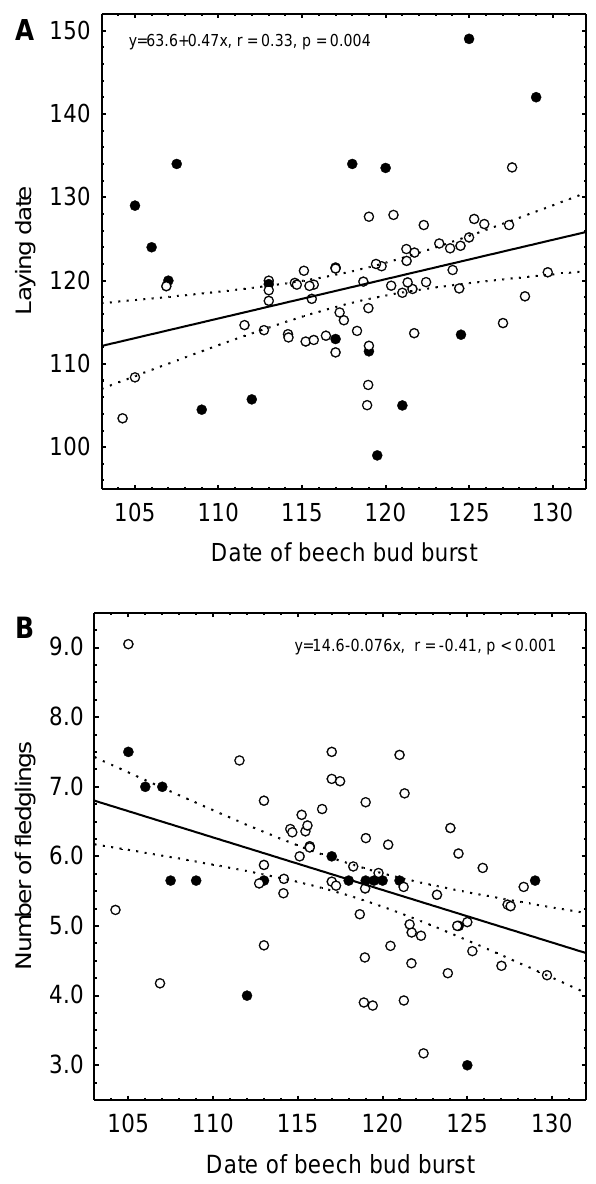
Fig. 1. (a) : average annual laying date; (b) average annual number of fledglings per great tit brood in relation to the date of beech bud burst 1901–1999. Circles: years with 5 and more broods included. Figure 1. ( a ): Average annual laying date; ( b ) average annual number of fledglings per great 1 Dots: years with brood sample size below tit brood in relation to the date of beech bud burst 1901 – 1999. Circles: years with 5 and 2 more broods included. Dots: years with brood sample size below 5. 3